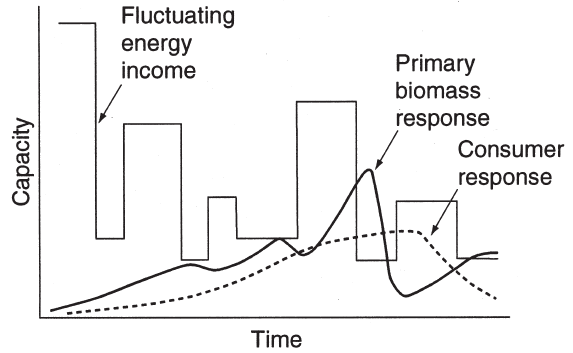
F IG . 2. – Assembly of producer biomass (continuous bold line) in relation to the ability of a fluctuating energy income (thin line) to sustain the mainteance requirements of the biomass. A similar rela- tionship exists between the biomass of consumers and the ability of the food resource to meet its maintenance costs. Based on Figure 65 of Reynolds